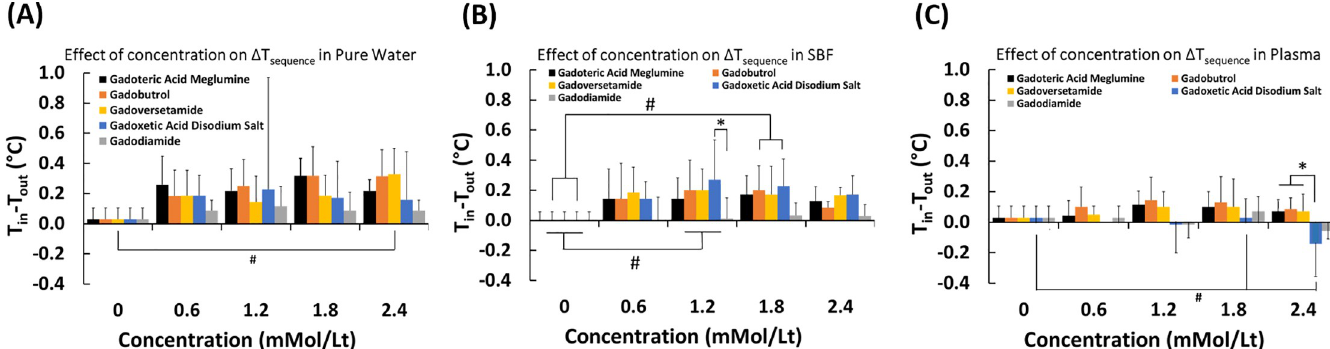
Fig 1. Effect of GBCA concentration and type on temperature change within sequences in different dilution media. (A) pure water, (B) Simulated body fluid-SFB, (C) plasma. Concentrations: 0.6, 1.2, 1.8, 2.4 mMol/L.